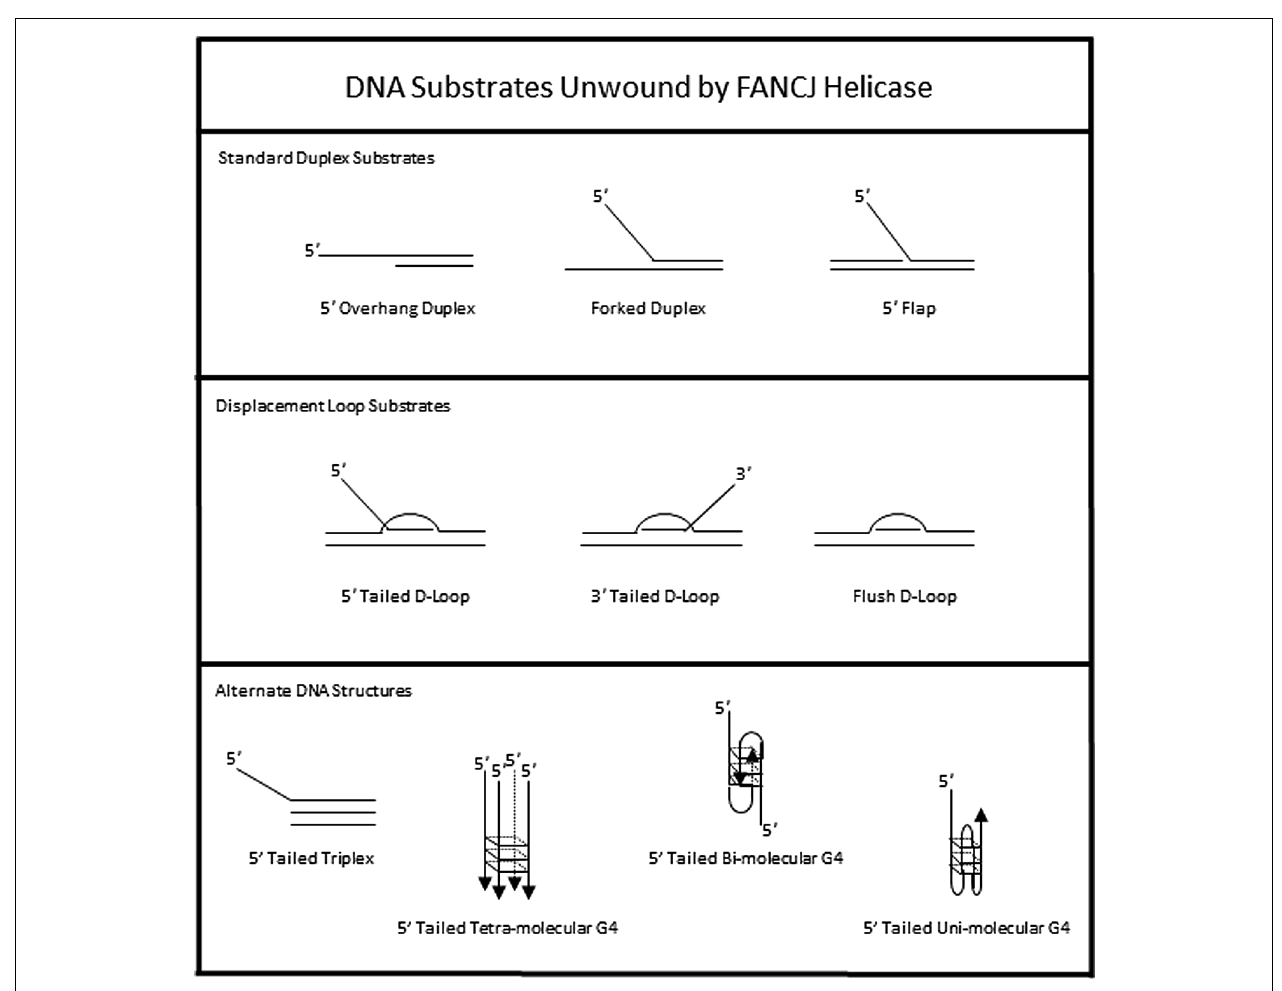
FIGURE 3 | DNA substrate specificity of FANCJ helicase. See text for